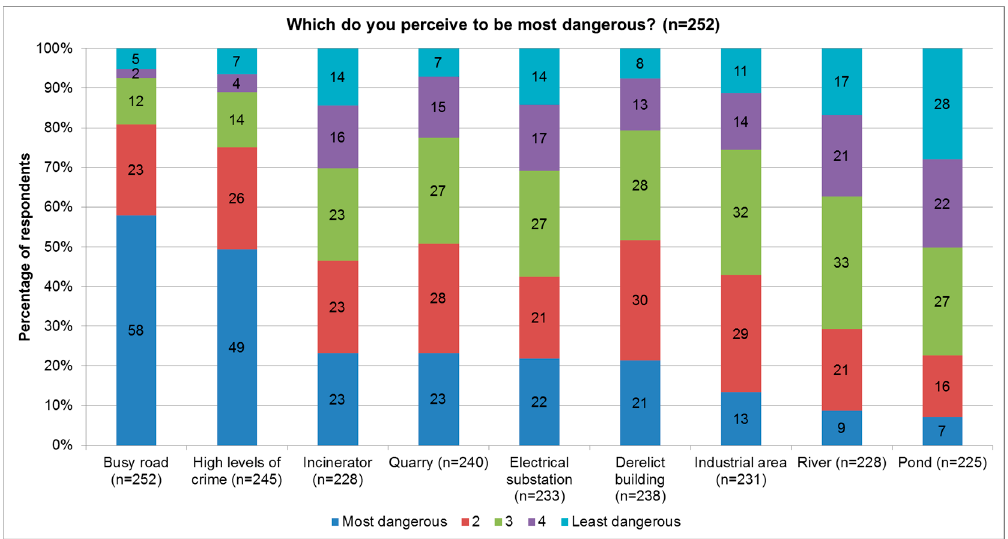
Figure 6. Which do you perceive to be the most dangerous, rated 1: Most dangerous to 5: Least dangerous.